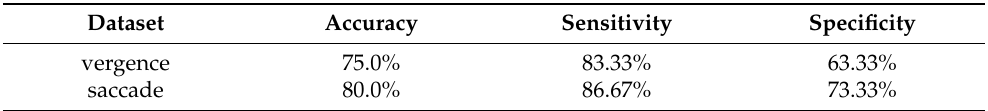
Table 6. Support vector machine scores when using the DGI feature on the saccade and vergence dataset.